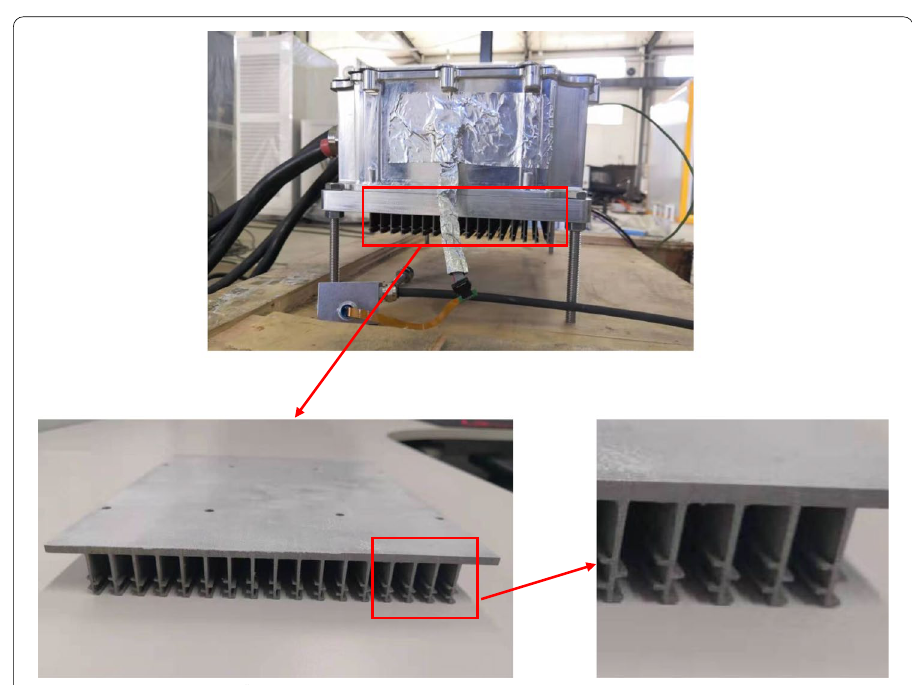
Fig. 12 Optimal design 11 # for the heat sink with MCRFs